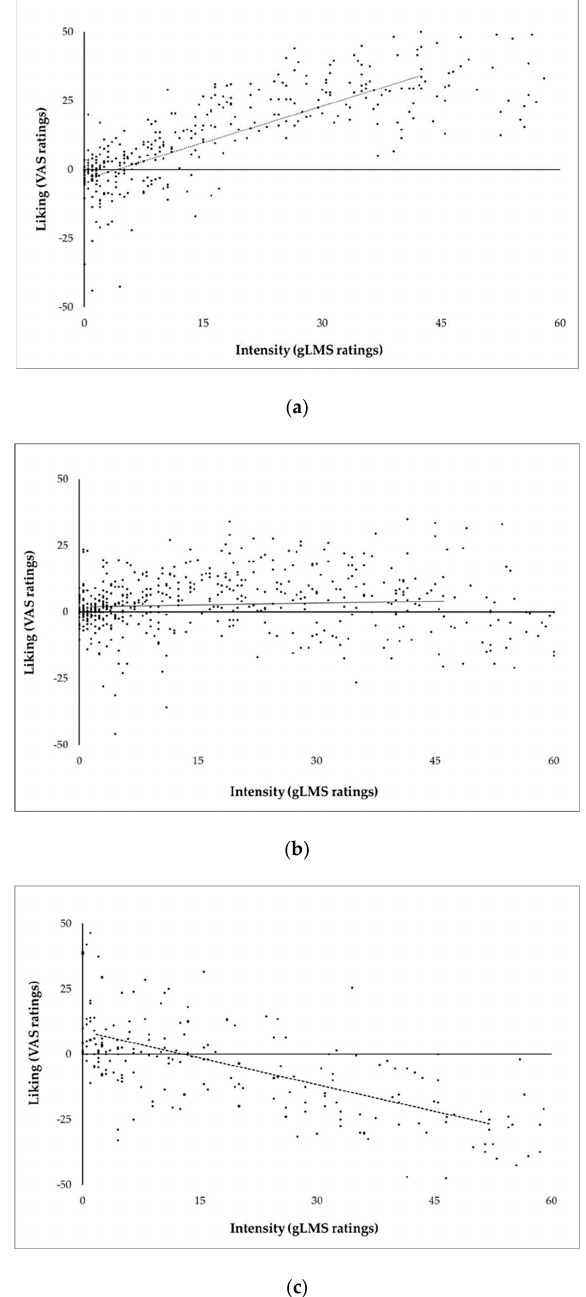
Figure 5. Individual ratings of liking as a function of perceived intensity for the sweet taste stimuli in ( a ) sweet likers, ( b ) individuals exhibiting an inverted U-shaped hedonic response, and ( c ) sweet dislikers. Lines represent the average ratings across individuals classified within each phenotype.